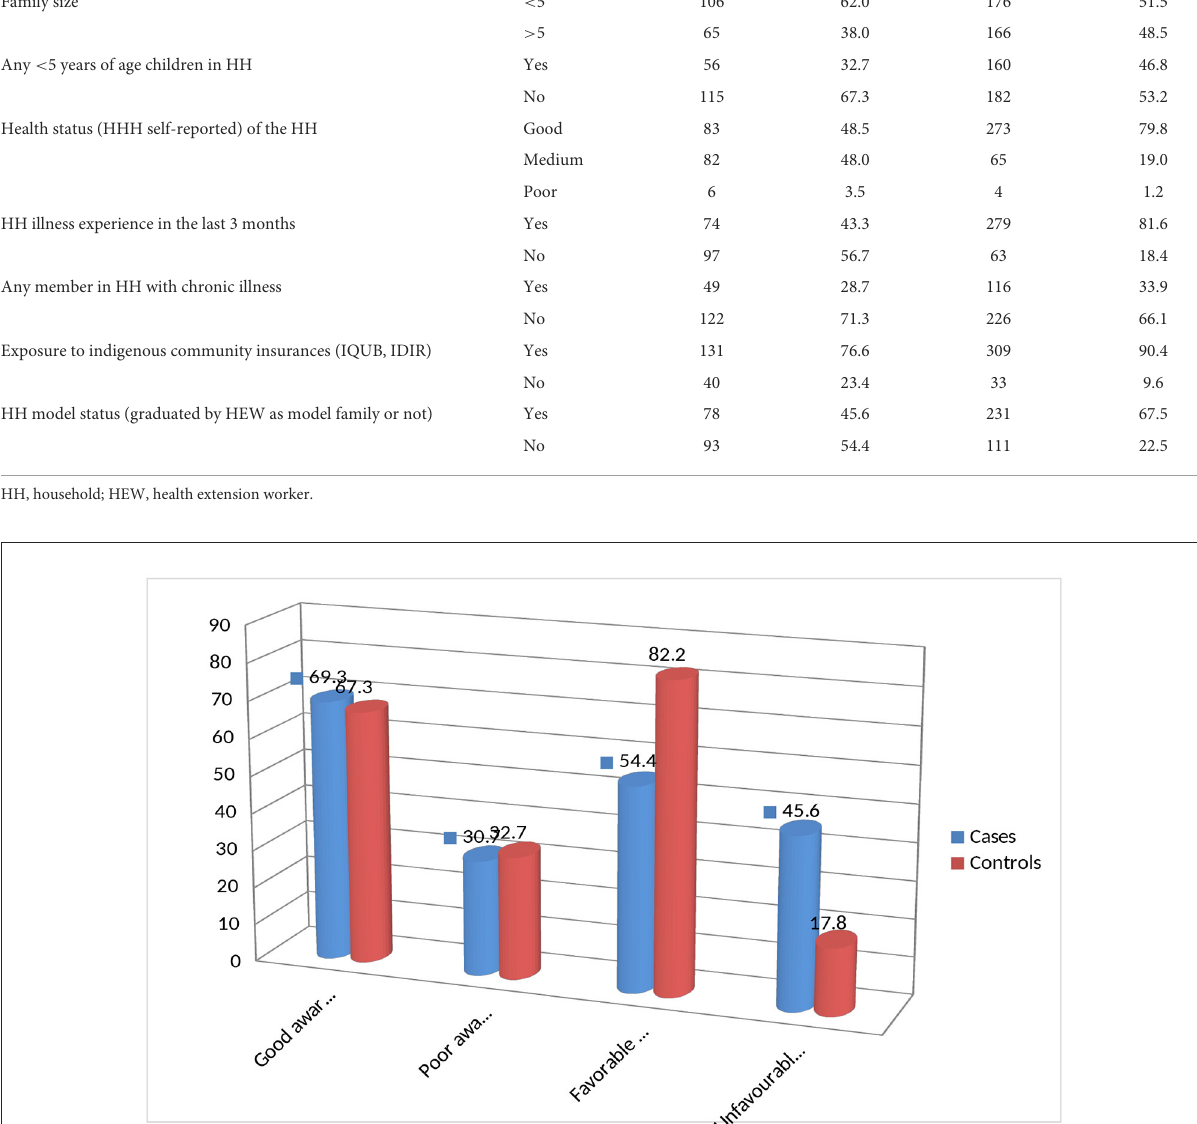
challenges in the drug availability. “And some patients in chronic care follow-up who are referred to Atat Hospital complain that they must have a referral for every visit and that is uncomfortable. [Male, 29 years old, health center